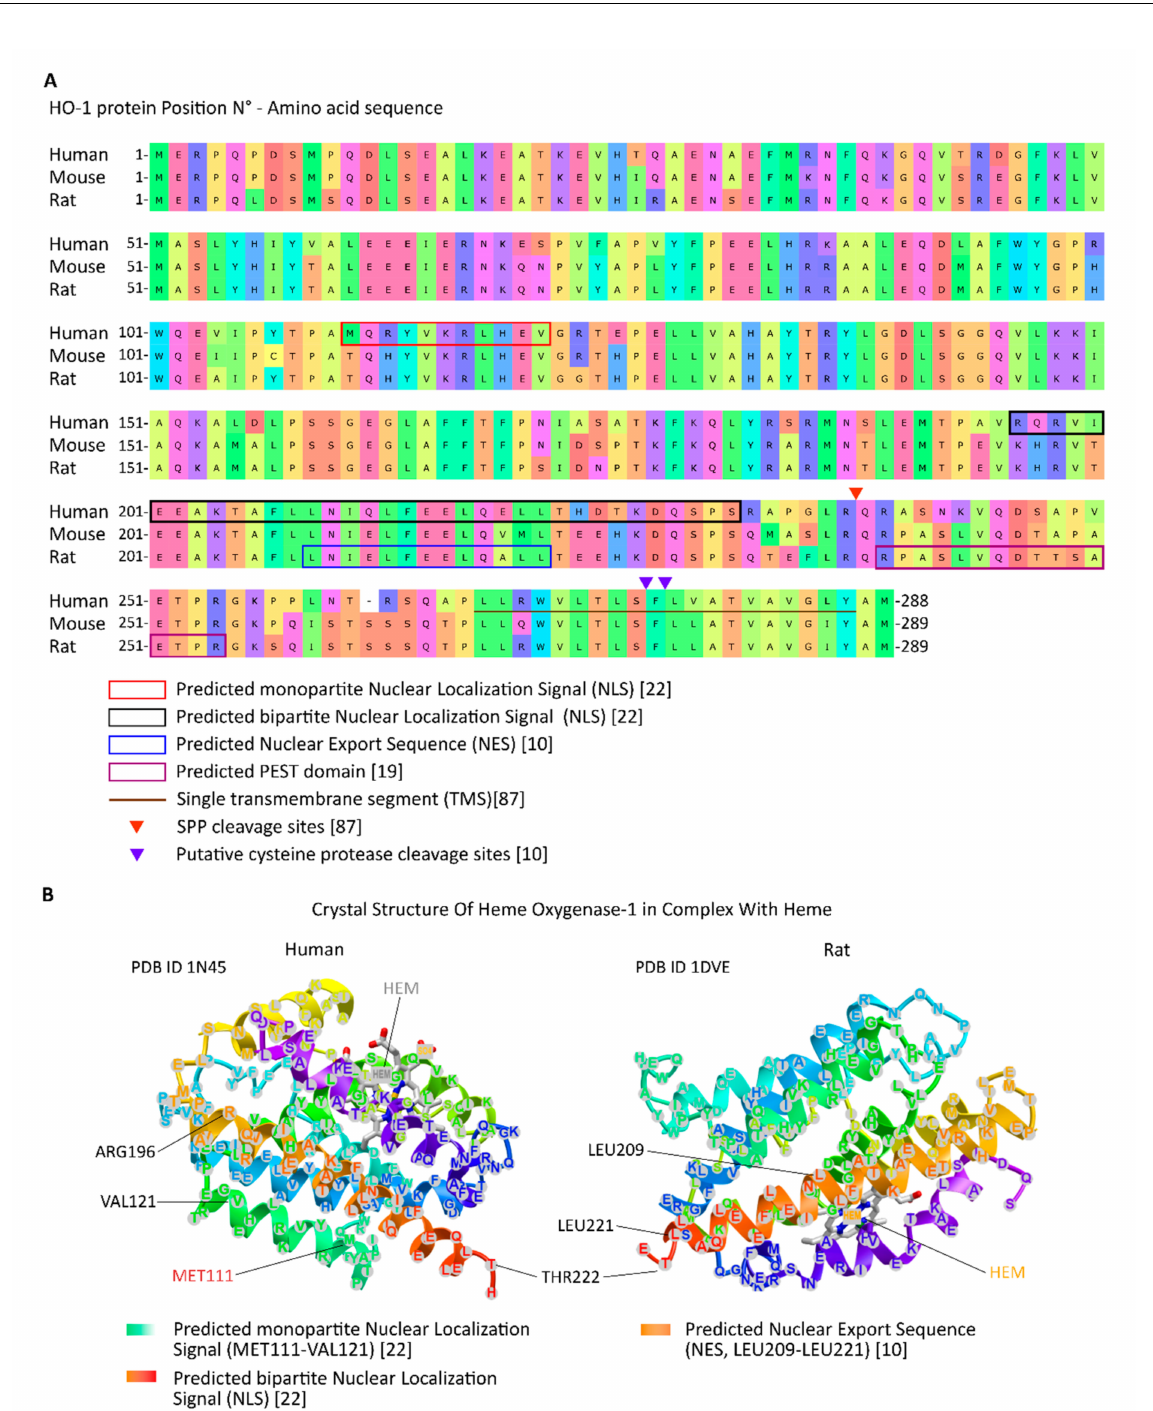
Figure 1. ( A ) Critical regions for proteolytic cleavage by SPP and cysteine proteases, and for proteasome degradation, as well as the TMS and the predicted nucleocytoplasmic shuttling (NES and NLS) sequences are indicated in the amino acid sequence for HO-1 protein. ( B ) Regions for predicted nucleocytoplasmic shuttling (NES and NLS) sequences and the heme-binding site are indicated in 3D models of HO-1